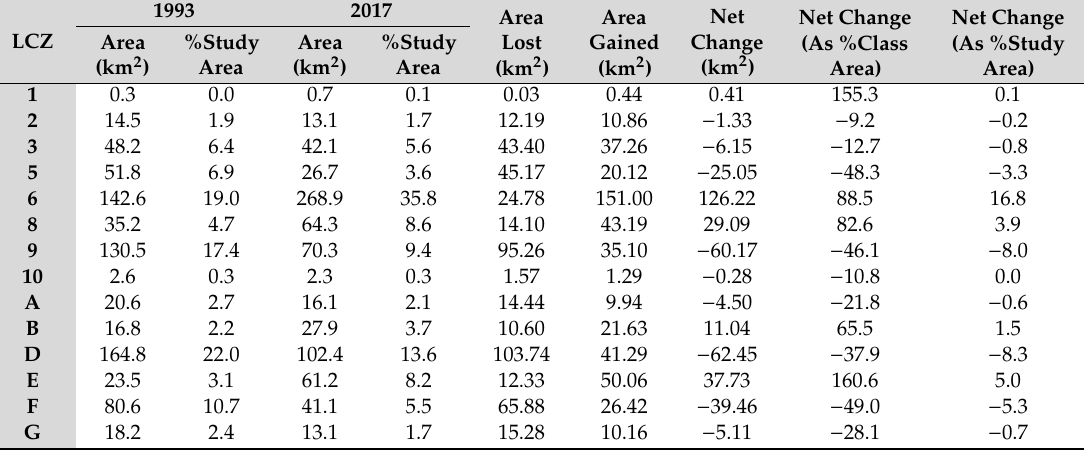
Table A4. Changes in spatial extents of mapped Local Climate Zones between 1993 and